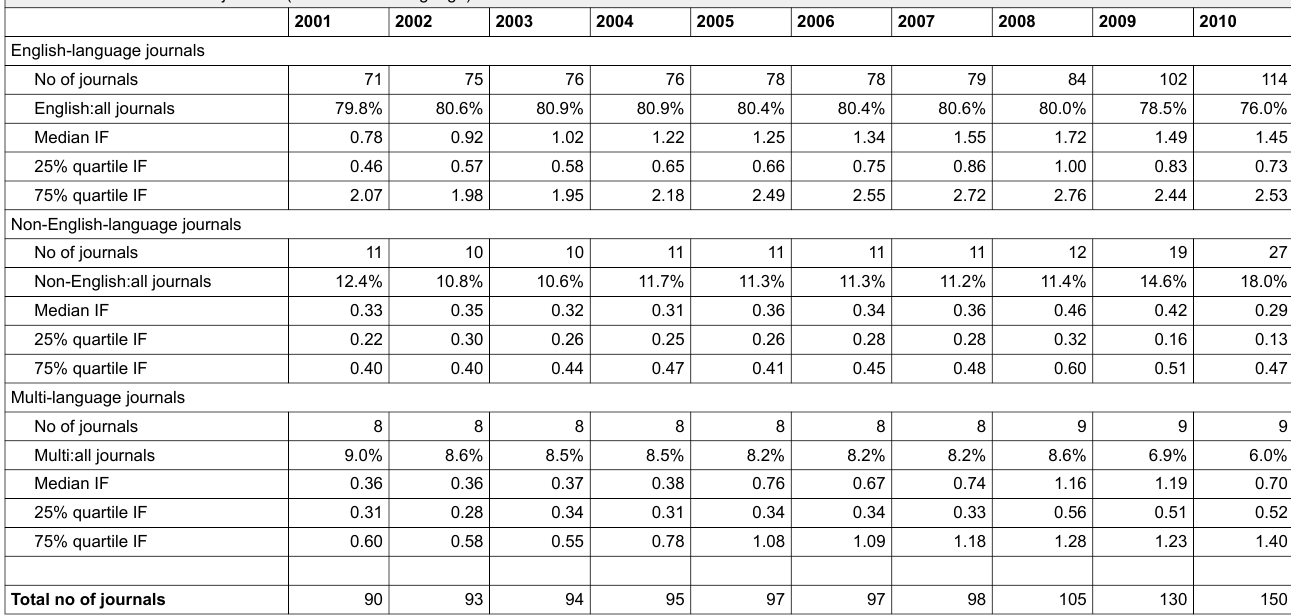
Table 1a: Characteristics of journals (classification: